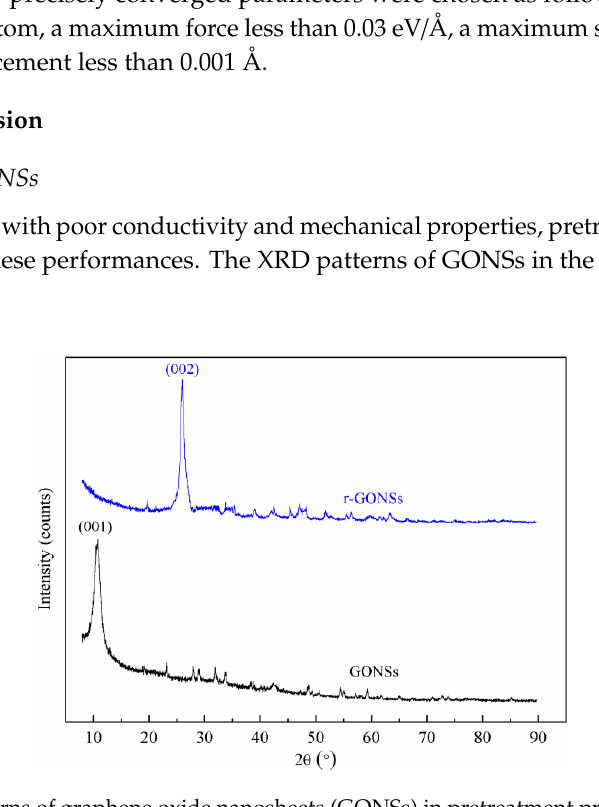
Figure 2. XRD patterns of graphene oxide nanosheets (GONSs) in pretreatment processes obtained in a nitrogen atmosphere.